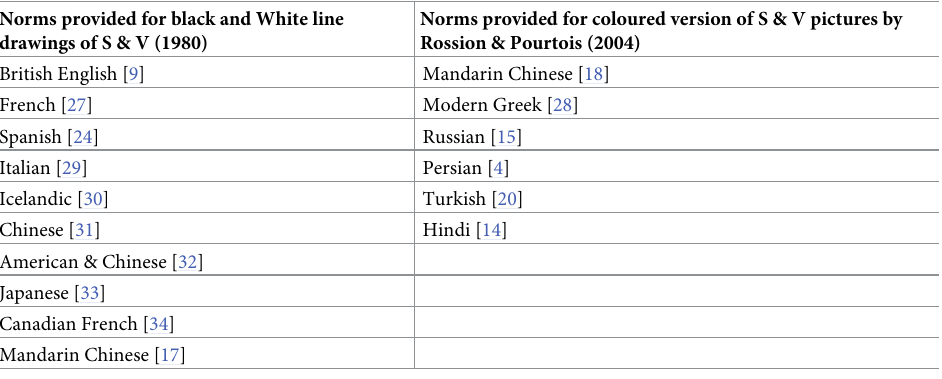
Table 1. Summary of norming studies carried out in different languages. Norms provided for black and White line drawings of S & V (1980)